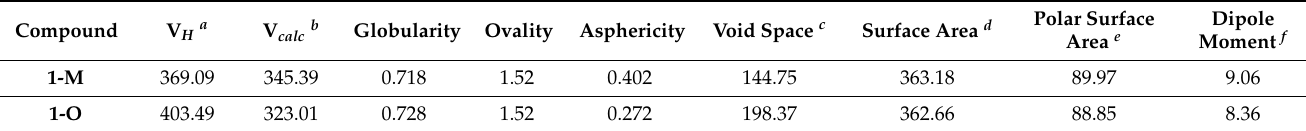
Figure 19. A representative packing of the compounds with the Hirshfeld surfaces mapped with the electrostatic